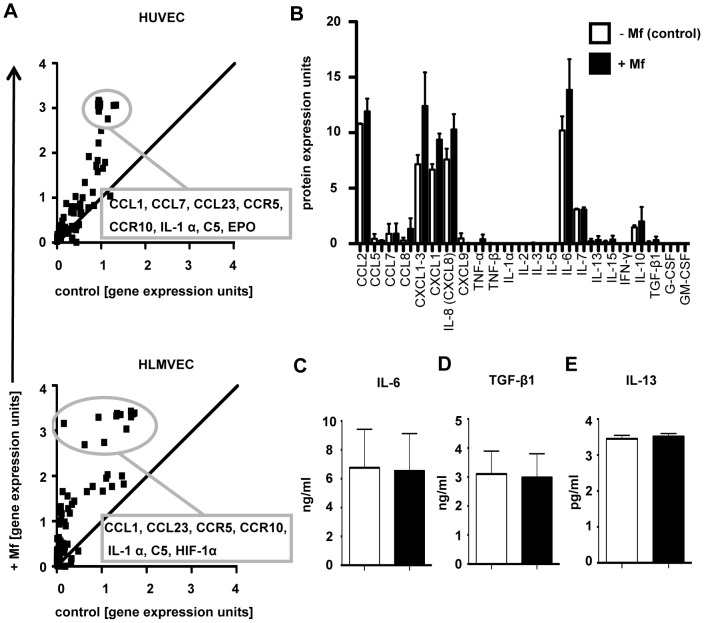
Live B. malayi Mf presence does not alter gene expression of vascular EC cytokine, chemokine and chemokine receptors.HUVEC or HLMVEC were cultured with live B. malayi Mf for 24 hours prior to isolation of total EC RNA, harvest of supernatant or cell lysis. An oligo microarray was used to analyse mRNA expression of various cytokines, chemokines and chemokine receptors. Genes with the greatest differences in expression upon Mf exposure are circled in (a). Oligo microarray data are shown as the mean of two independent experiments. HUVEC supernatant was analysed for protein expression of various cytokines using a protein array (b) or the cytokines IL-6 (c) and TGF-β1 (d) were measured by ELISA. IL-13 was measured in HUVEC lysate by ELISA (e). Protein assays show the mean and standard deviation per group of two (protein arrays) or three (ELISA) independent experiments. The label CXCL1-3 in the protein array defines the measurement of a common epitope for CXCL1, CXCL2 and CXCL3.